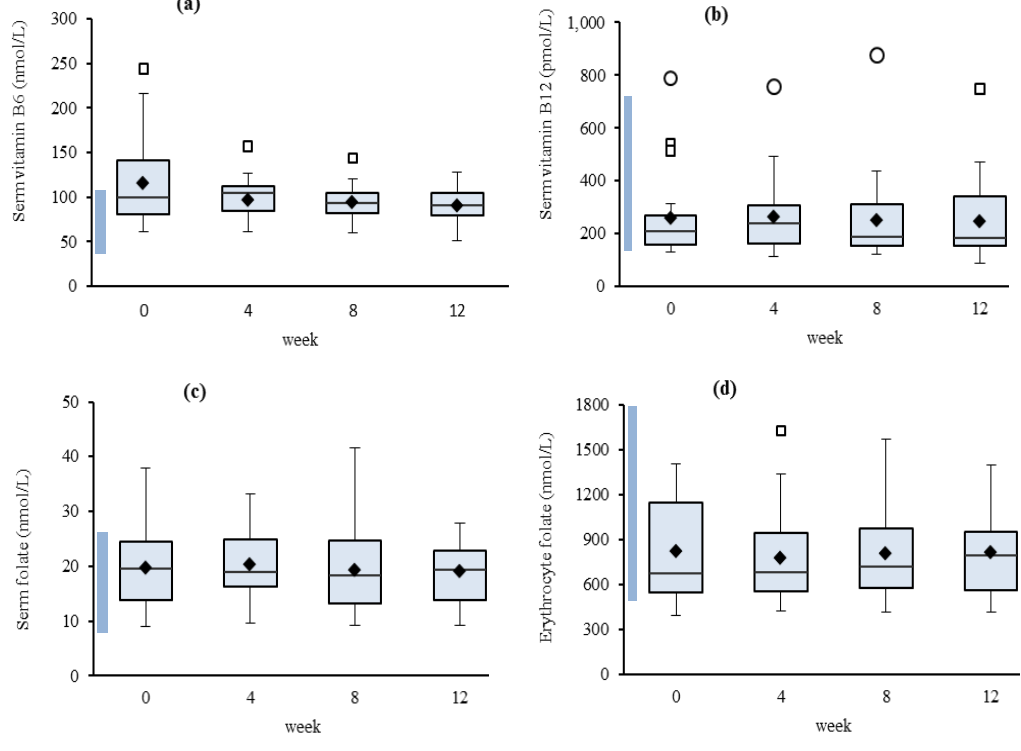
Figure 1. Mean s erum vitamins B ( d ) concentrations ( n = 22). . Reference intervals (shaded) [12], mean (♦) and outliers (□,